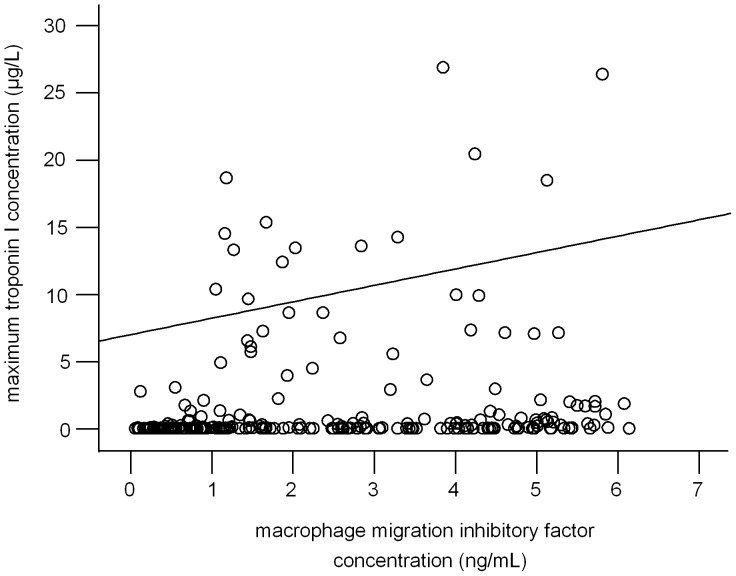
Correlation of the extent of maximum TnI release after PCI in the study cohort.